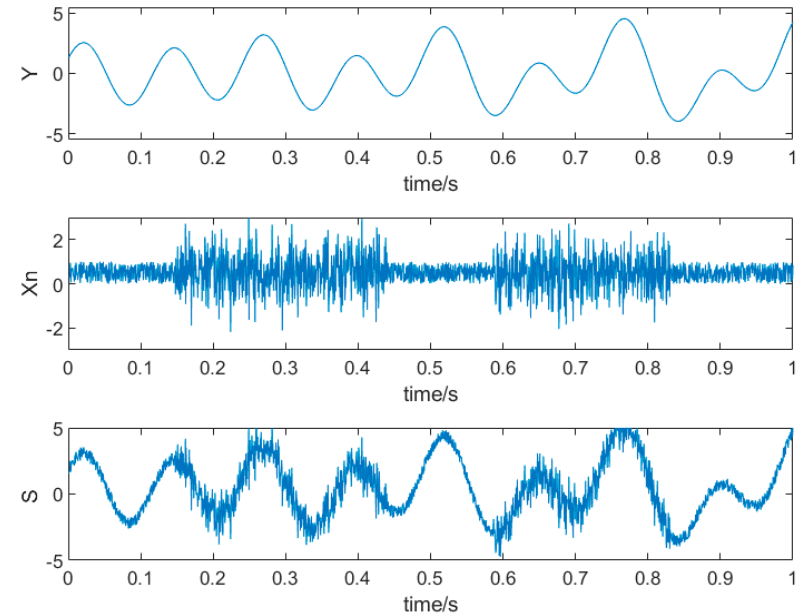
Figure 2. Simulation signal, noise signal, and simulation signal with noise.